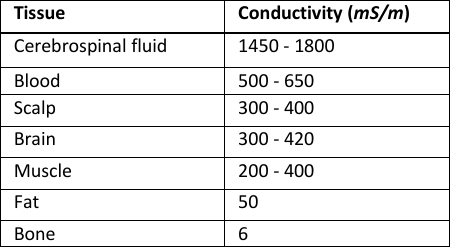
Table 2: Electrical conductivity for Human tissues.